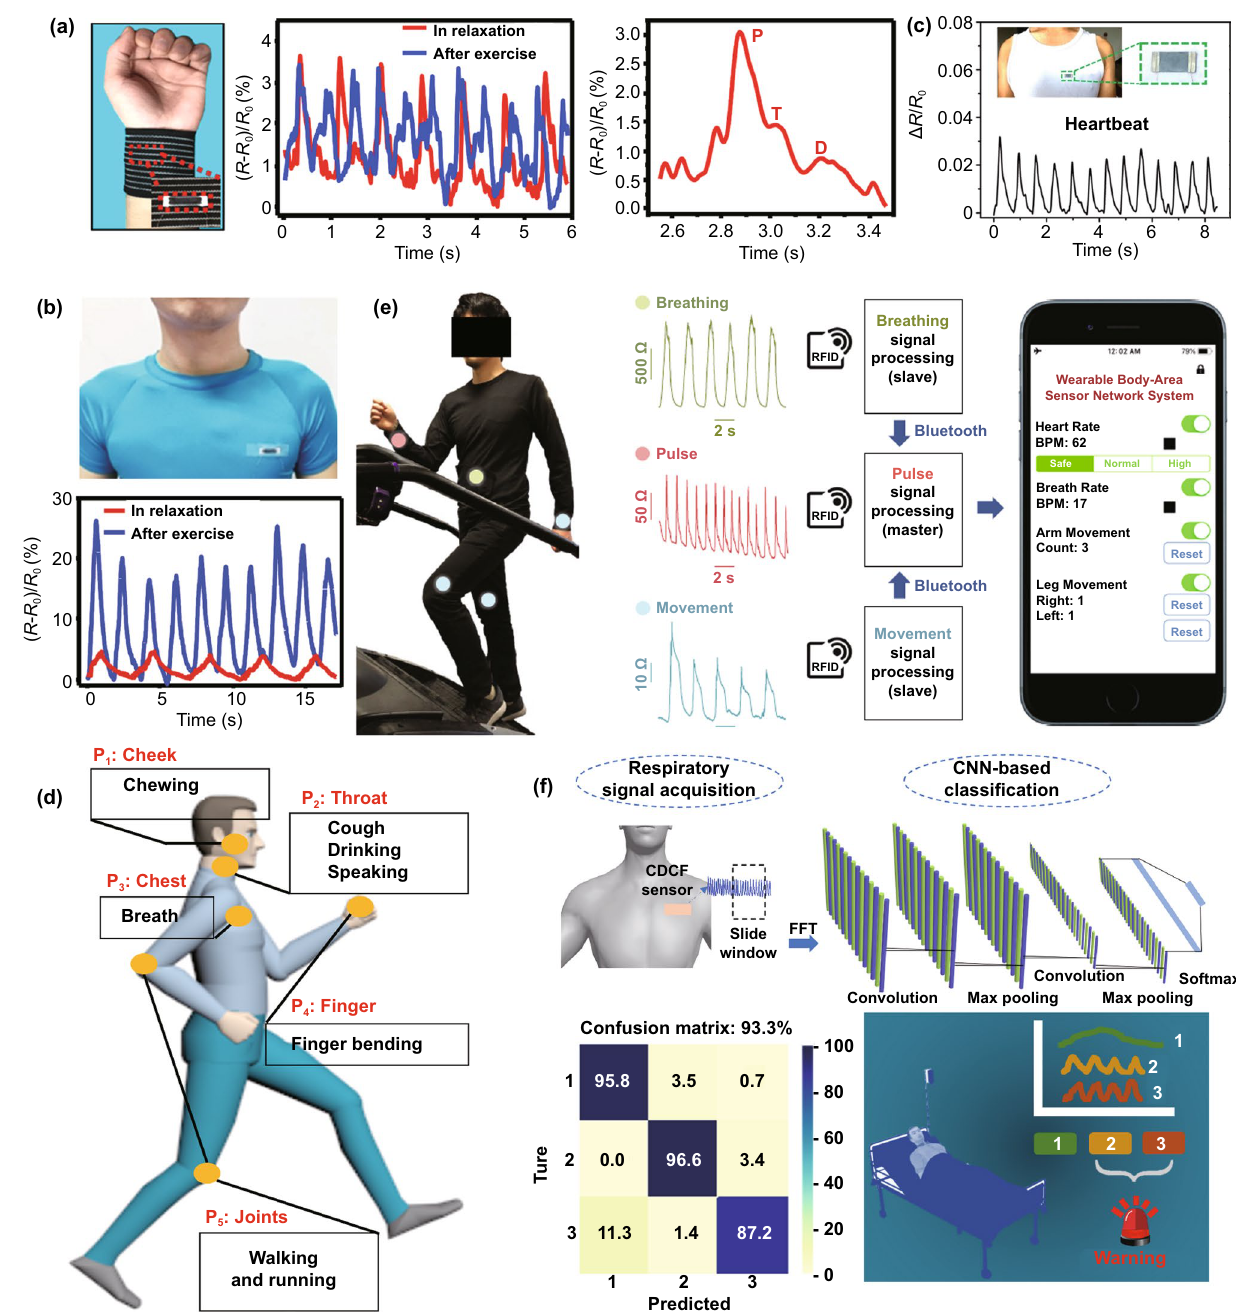
Fig. 10 a The detection of the wrist pulse by assembling a carbonized silk fabric-based strain sensor on the wrist surface, and b real-time res- piration monitoring by attaching the sensor to the location of chest surface [90]. Copyright © 2016 Wiley–VCH. c The signals of heartbeat col- lected by a PDMS-supported conductive polymer [205]. Copyright © 2018 American Chemical Society. d An overview of the locations of body sensing networks based on embroidery strain sensors [6]. Copyright © 2021 Wiley–VCH. e The photograph of body sensing networks in moni- toring breathing, pulse, and arm movement [206]. Copyright © 2019 Springer Nature. f A respiration monitoring and emergency warning system based on a strain sensor and a deep learning network [153]. Copyright © 2021